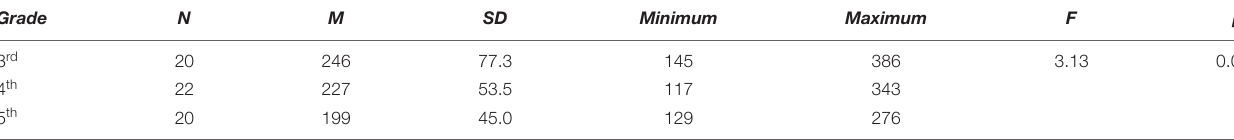
TABLE 2 | First fixation duration (ms): descriptive statistics and comparison within grades. Grade